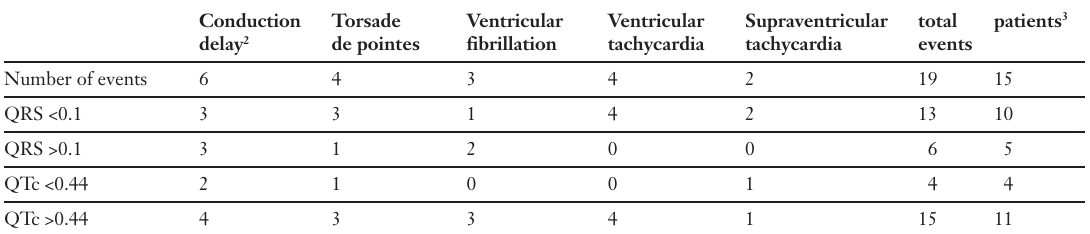
Adverse cardiac events in 15 of 103 patients with pre- sumed antidepres- sant intoxication 1 .